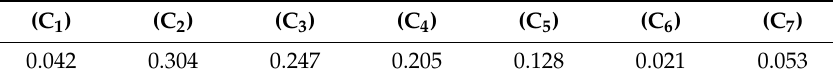
Table 4. Final weights of each